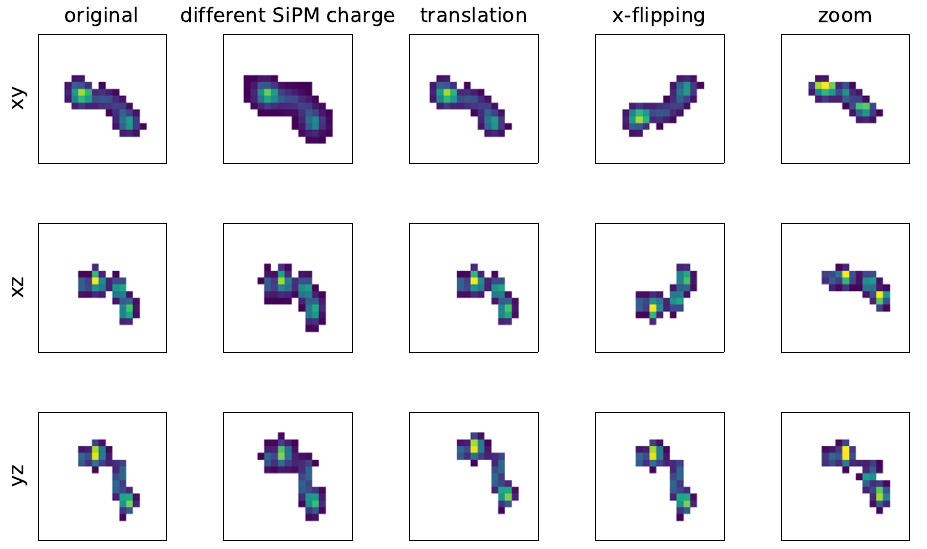
Figure 6 . Example of on-the-fly data augmentation used during training on a selected signal event, projected on three planes for easier